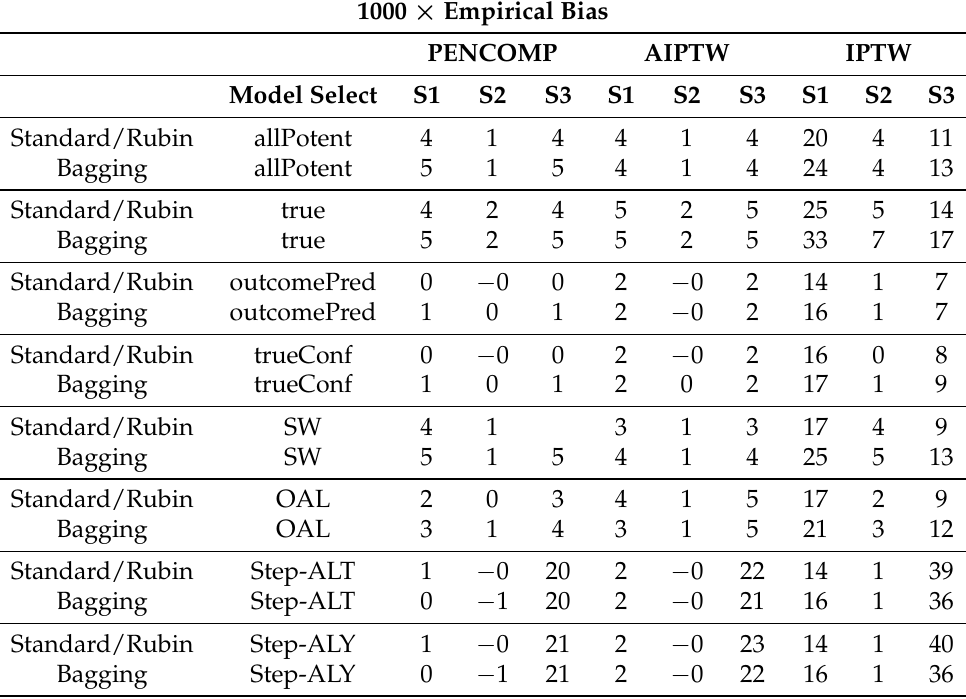
Table A3. 1000 × empirical bias with sample size of 1000. The treatment effects η = 2. S1, S2, and S3 denote scenario 1, 2, and 3, respectively.